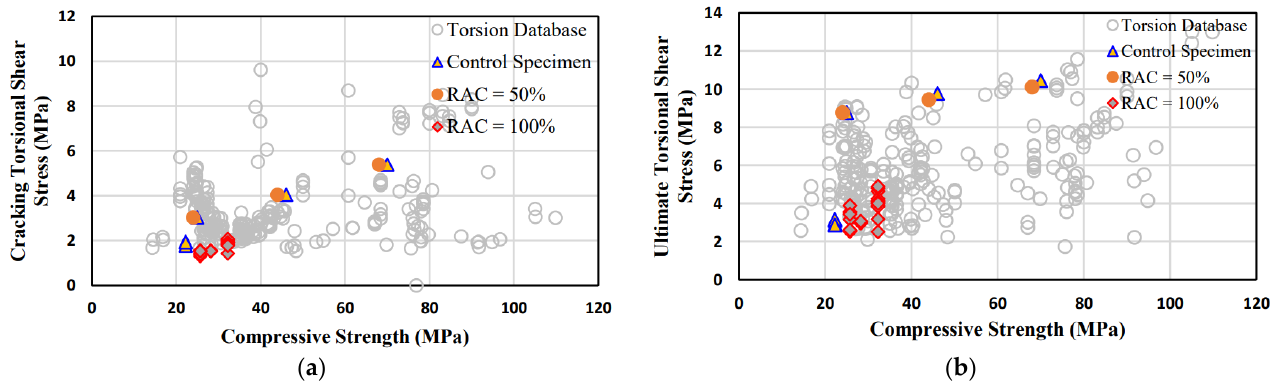
Figure 3. Effect of compressive strength: ( a ) on cracking torsional shear stress; ( b ) on ultimate torsional shear stress.